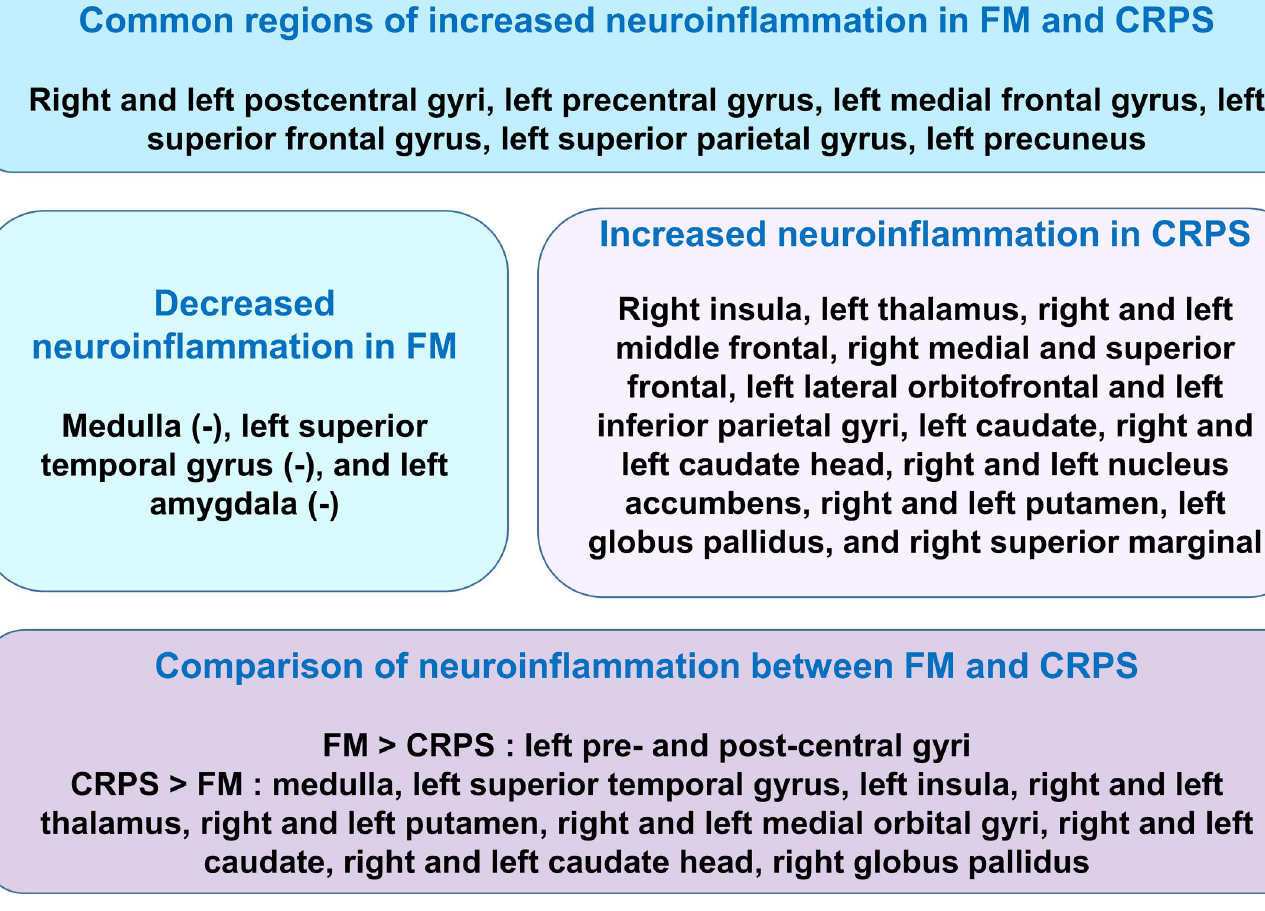
PLOS ONE | https://doi.org/10.1371/journal.pone.0246152 February 8,